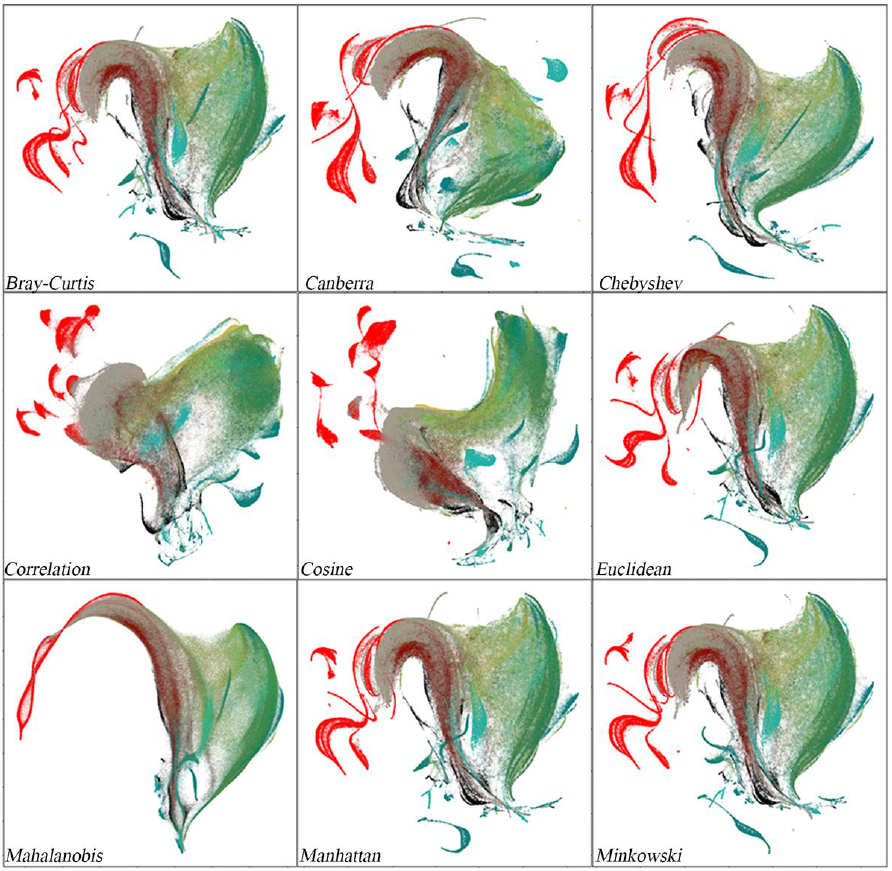
Figure A4. UMAP dependence on choice of distance metric. Results are shown for the image mosaic. All runs use 30 nearest neighbors and min_dist = 0.1.